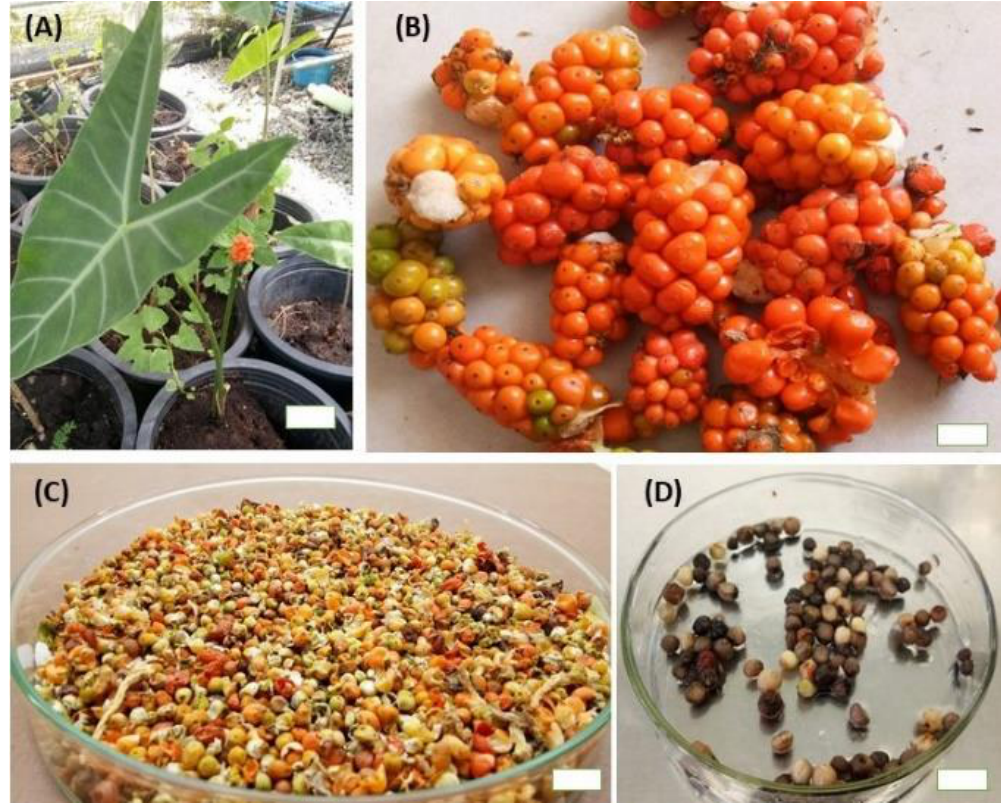
Figure 1. Plant material used to establish micro-propagation of A. longiloba . ( A ) A. longiloba plant collected from field; ( B ) ripened fruit harvested from field grown A. longiloba plant; ( C ) dried fruit; ( D ) seeds isolated from dried fruit of A. longiloba (bar: 1 cm).